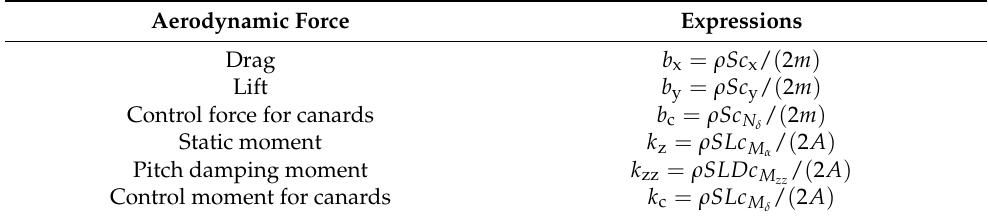
Table 1. The plural form of aerodynamic